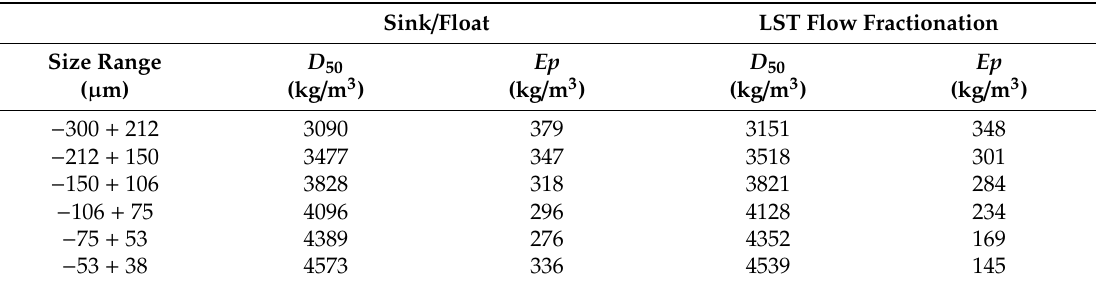
Algorithm solutions comparing the results based on the sink / float and lithium heteropolytungstates (LST) flow fractionation data. The partition parameters ( D 50 , Ep ) are shown for the narrow particle size